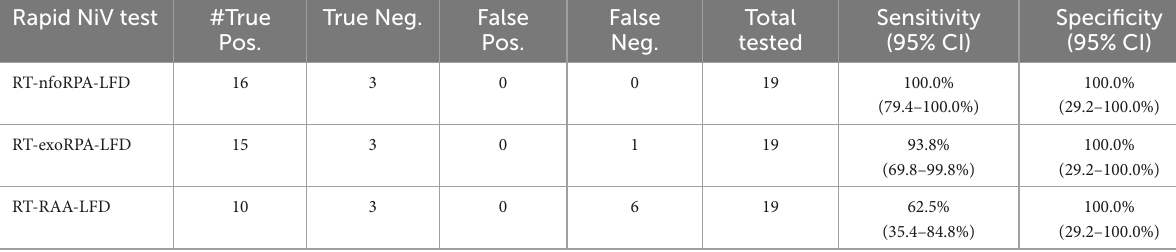
TABLE 2 Diagnostic test evolution of three rapid Nipah virus (NiV) tests. Rapid NiV test #True True Neg. False Pos.